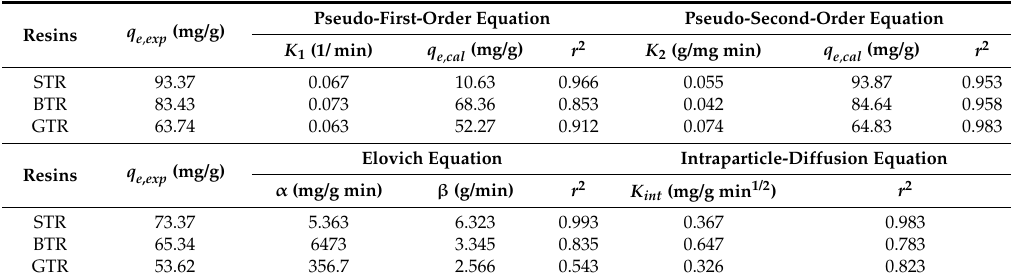
Table 4. Comparison of four isotherm equations for equilibrium uptake studies of Pb 2+ by the three resins.